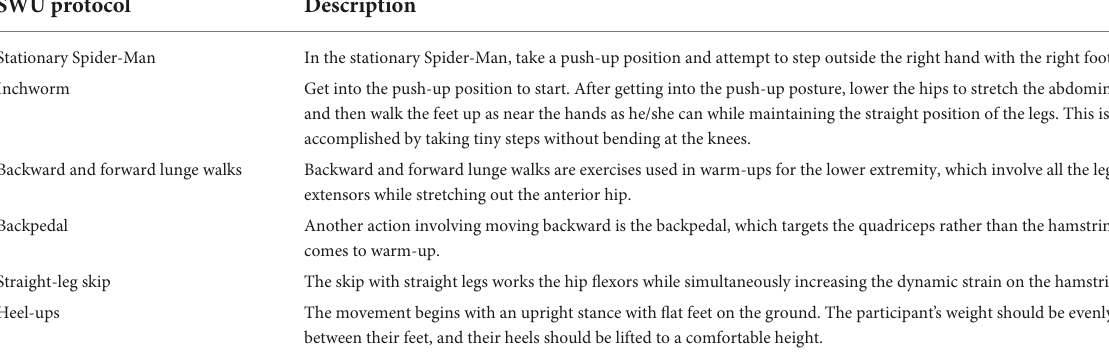
TABLE 1 Specific warm-up